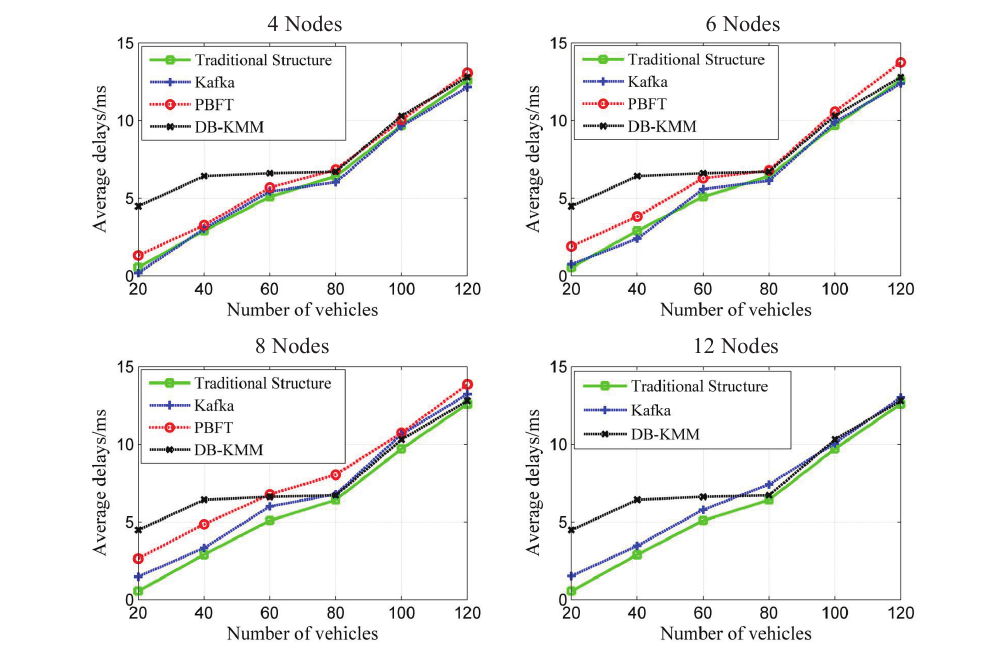
Figure 9. Delay of different